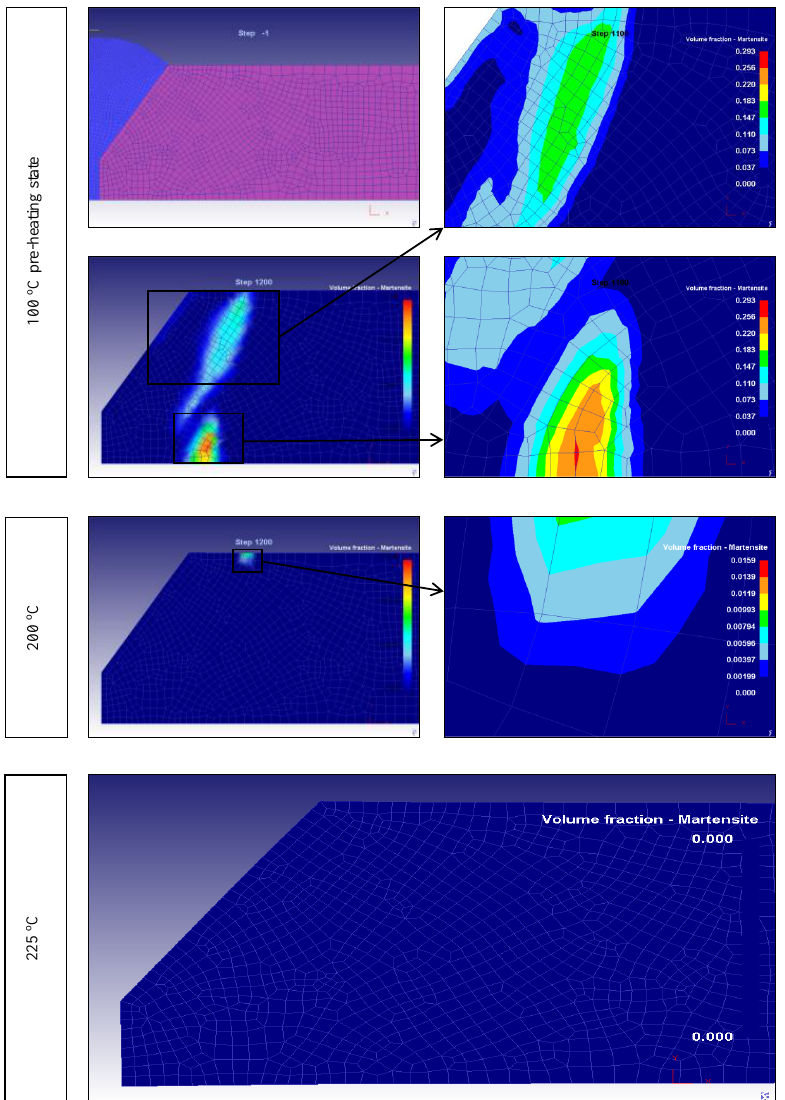
Figure 13. Elimination of martensite formation phase transformation of the AISI 1045 steel for different pre-heating temperatures. Metals 2017 , 7 , 41